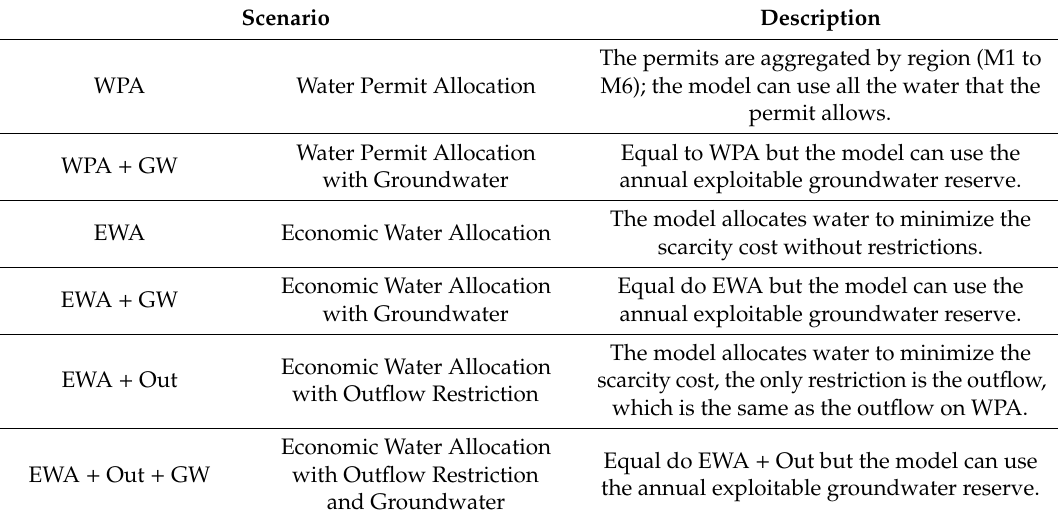
Table 2. Scenarios and water allocation strategies simulated on the hydro-economic model. Scenario Description WPA Water Permit